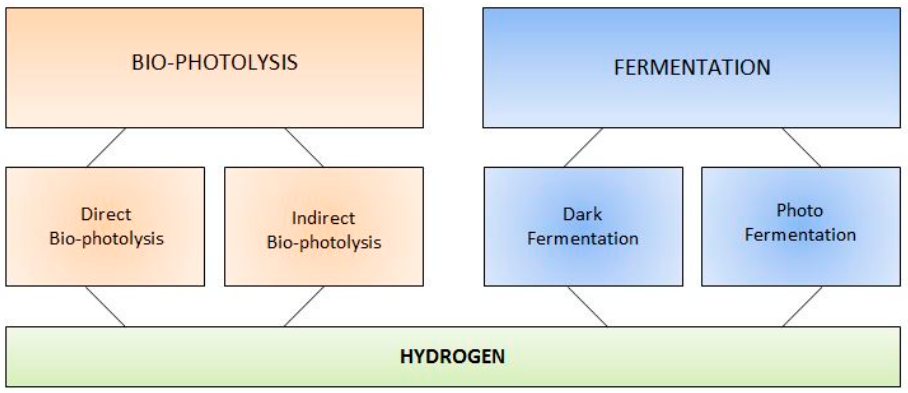
Figure 1. Hydrogen production processes in microalgae .